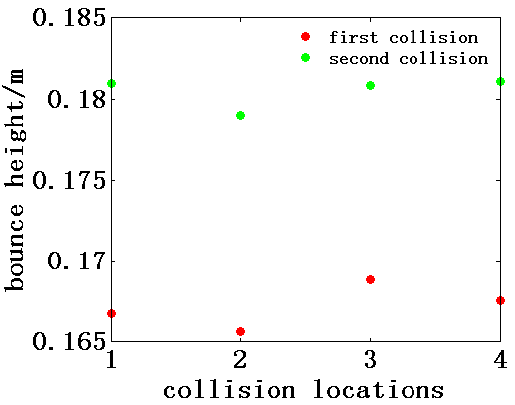
Figure 10. Test data of the steel plate collision repeated experiments.